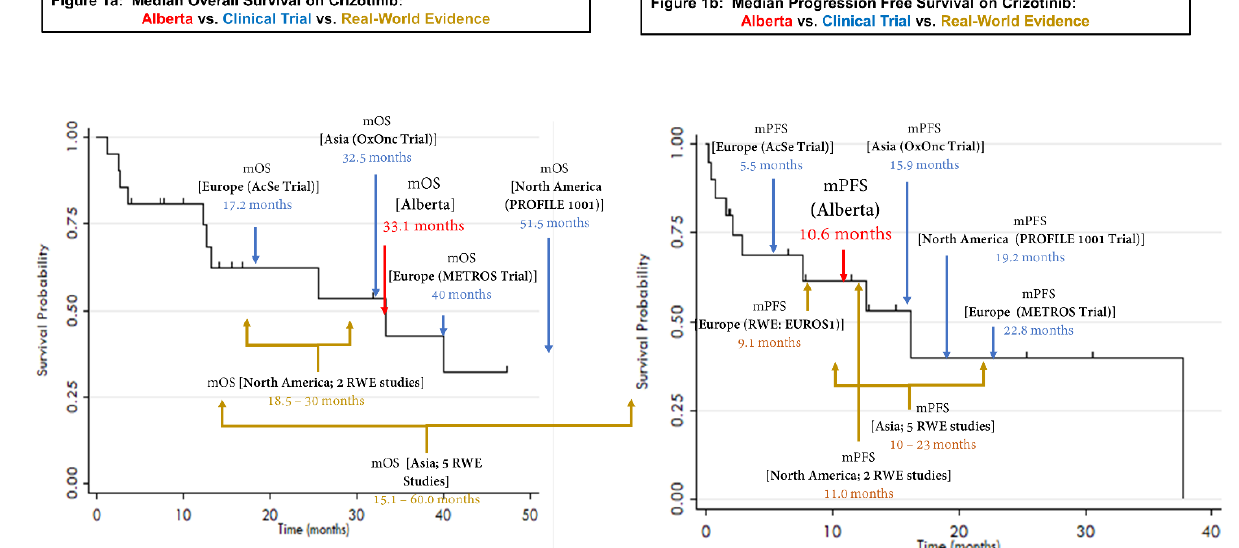
Figure 1. Alberta vs. clinical trial vs. real-world cohorts. Median overall survival on crizotinib ( a ); median progression-free survival on crizotinib ( b ) .